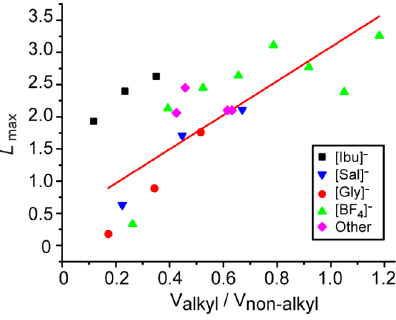
Figure 5. The maximum values of librations, L max , vs. the ratio of alkyl-chain volume to the volume of rest of the IL–ion couple. The red line shows the linear fit of the presented data, excluding results for [Ibu] – API-ILs. Some data points are taken from previous research [28–30,32,33,42].